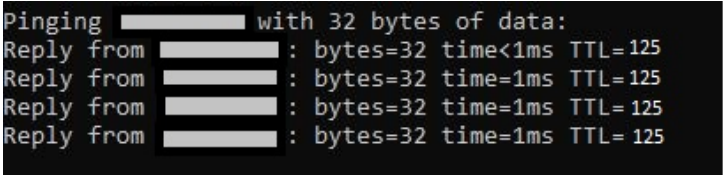
Figure 18. Propagation delay: Bangladesh to Japan and Japan to Bangladesh. Transmission delay also occurred in the experimental field (local communication) in Japan during wireless transmission commands from the Raspberry Pi transmitter to the electronic backpack. The transmitter sent stimulation commands to the backpack with a sampling rate of 10 Hz. In order to measure this transmission delay, a step input signal, as shown in Figure 17, was implemented as the transmitted signal. The signal received by the electronic backpack was measured using a serial monitor on Arduino IDE. Based on the obtained transmitted and received signals, the delay from the Raspberry Pi transmitter to the electronic backpack was 0.19 s, as depicted in Figure 19. Figure 19. The measured time delay in local wireless communication. The obtained average end-to-end time delay to control the biobot from Bangladesh to Japan is summarized in Table 4. The table shows that transmission and propagation delay Bangladesh to Japan and Japan to Bangladesh. The calculated average end-to-end time delay of this system was 275 ms. However, the time delay will be different in differ- ent circumstances depending on the internet connection speed. The obtained low time delay is still acceptable because the motion of the biobots is relatively slow. Therefore, a remote operator in Bangladesh could steer the cockroach on the path-following mission, as presented in 4.1.1 and 4.1.2. Table 4. Average end-to-end time delay to control the biobot. Destination